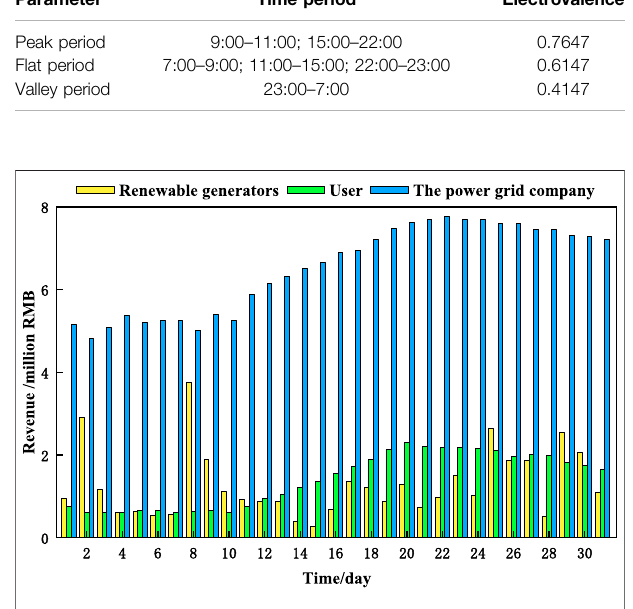
FIGURE 4 | Revenue results for each market